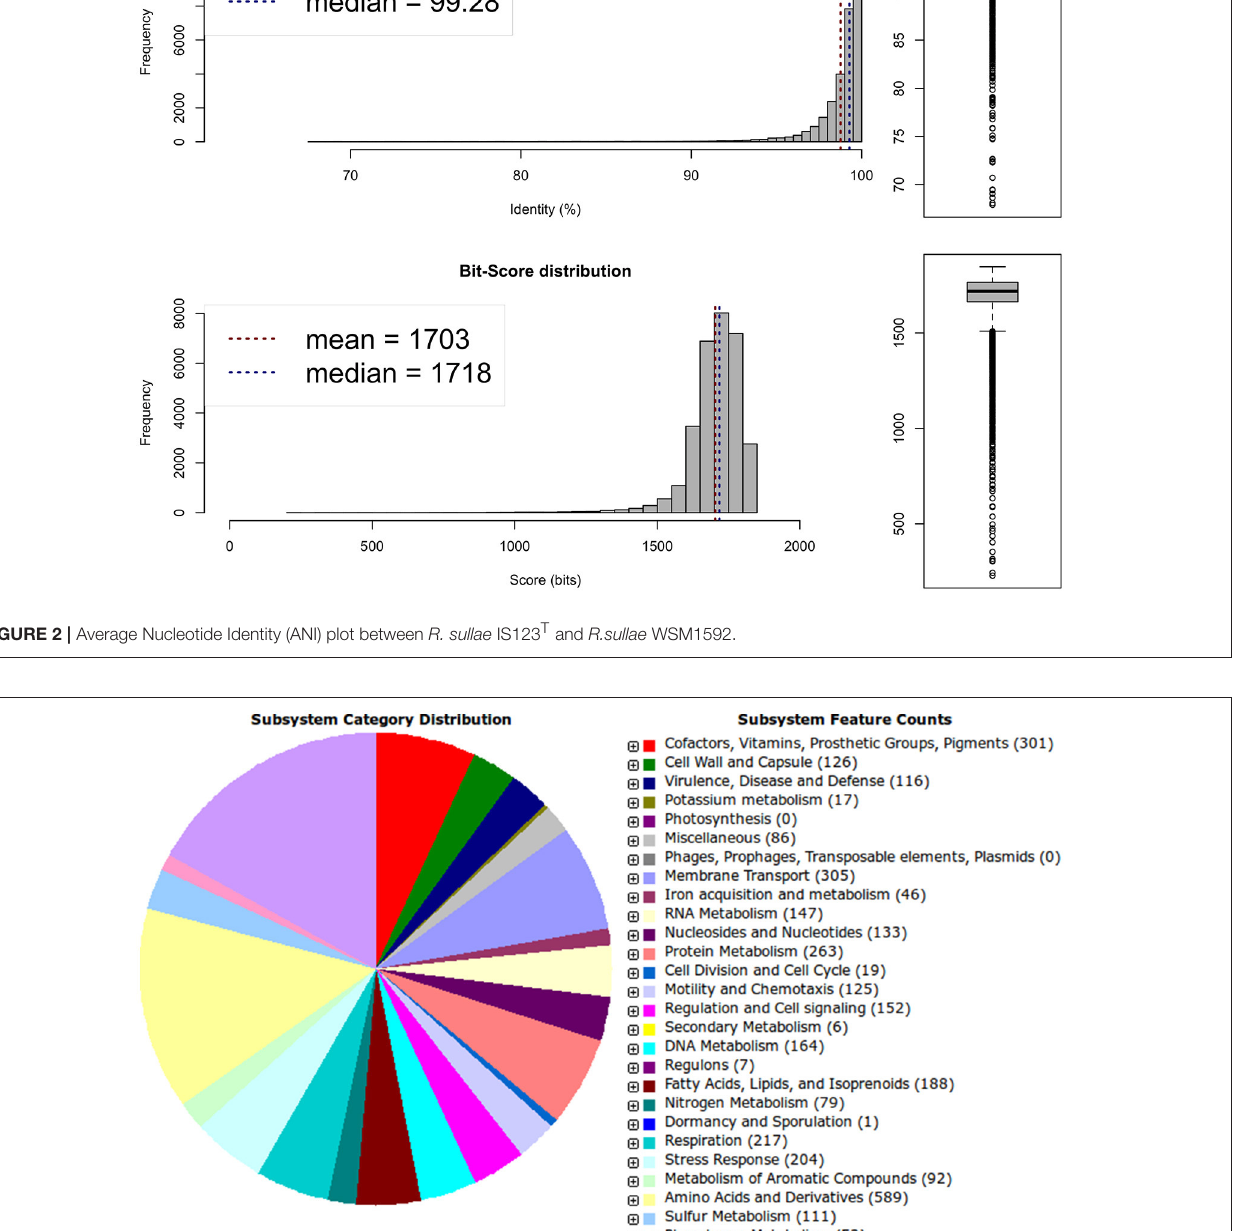
in bacteria this gene is reported to be related not to saline conditions, but rather to responses to organic hydroperoxides and reactive oxygen species in general (Lesniak et al., 2002).